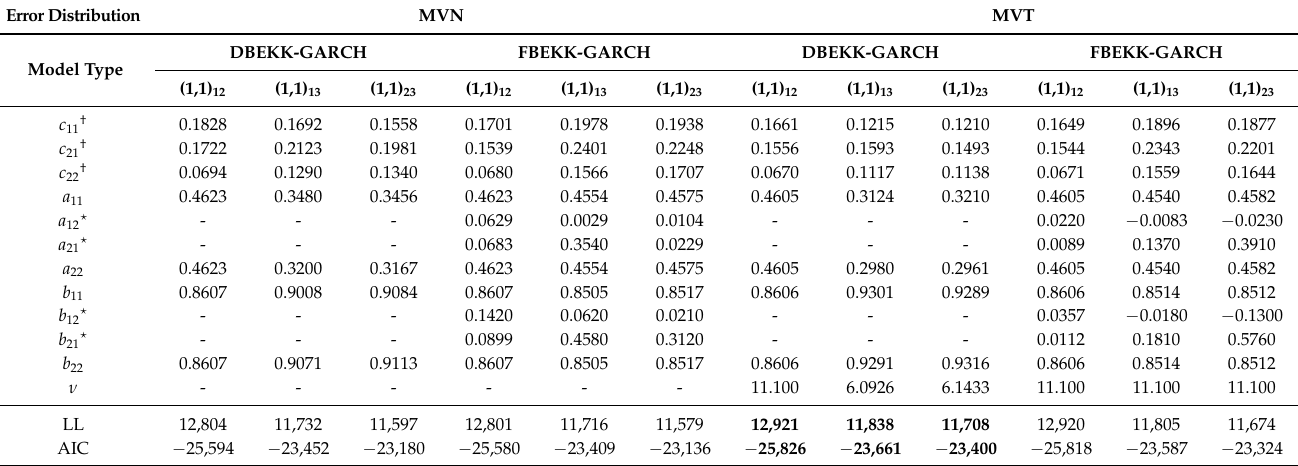
Table 6. Parameter estimates and model performance measures LL and AIC for in-sample estimation of the DBEKK-GARCH(1,1) and FBEKK-GARCH(1,1) models. Models with boldface LL and AIC are the best for each index